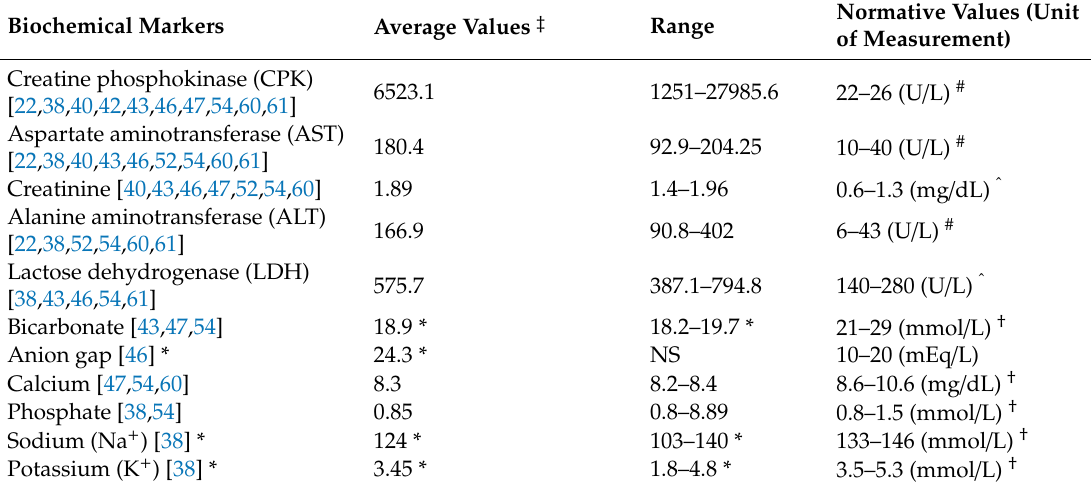
Table 5. Biochemical markers of Exertional Heat Stroke in the